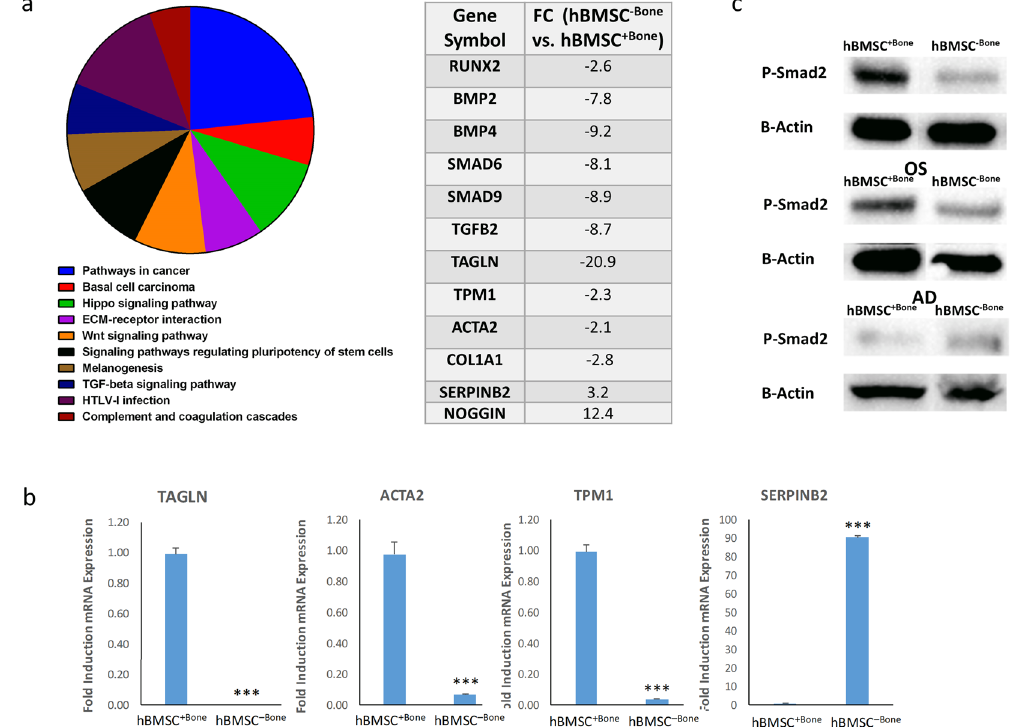
Figure 2. Impaired TGF β signaling in hBMSC − Bone cells. ( a) Pie chart illustrating the distribution of the top 10 KEGG pathways in the downregualted genes. The pie size corresponds to the number of matched entities. List of TGF β responsive genes, which were differentially expressed in hBMSC − Bone vs . hBMSC + Bone as revealed by whole genome microarray profiling is shown. (b) qRT-PCR validation for the expression of a panel of TGF β responsive genes (TAGLN, ACTA2, TPM1, and SERPINB2) in hBMSC − Bone compared to hBMSC + Bone cells. Expression of each target gene was normalized to GAPDH. Data is shown as the mean ± SD from three independent experiments, *** p < 0.0005. (c) Western blotting for P-SMAD2 in hBMSC − Bone compared to hBMSC + Bone cells (upper panel), whereas B-Actin (ACTB, lower panel) was used as a loading control. Phosphorylation of SMAD2 is also shown during the osteogenic and adipogenic differentiation of both cell